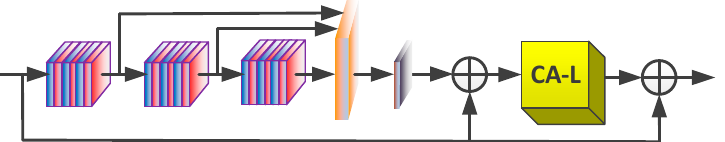
Figure 4. Details of the LFM which contains three convolution groups, two residual blocks, and one channel-wise attention module based on low variance.